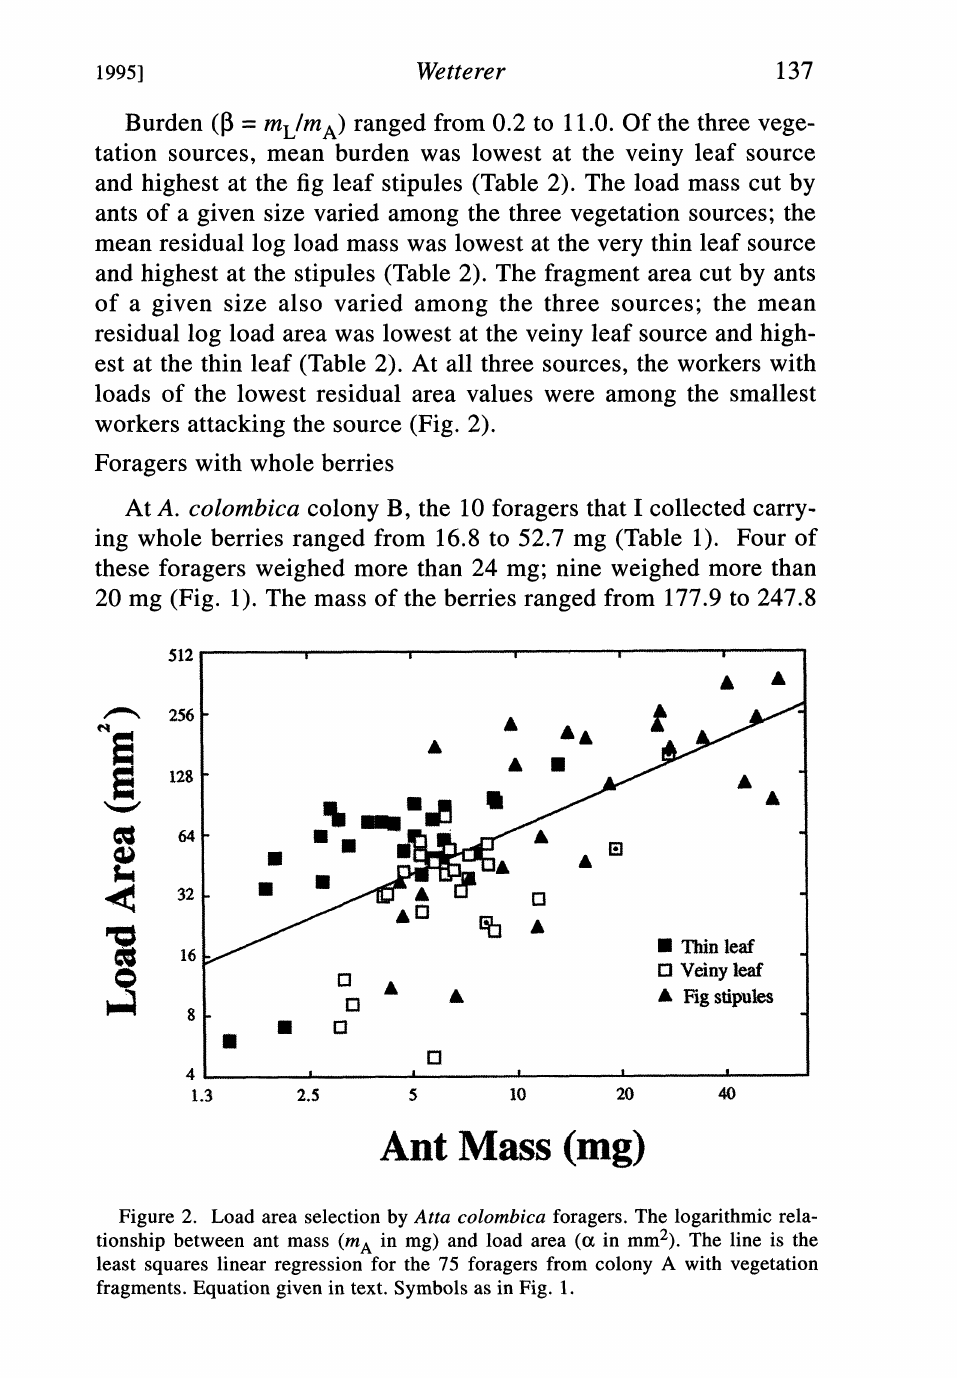
Figure 2. Load area selection by Atta colombica foragers. The logarithmic rela- tionship between ant mass (m A in mg) and load area (t in mm2). The line is the least squares linear regression for the 75 foragers from colony A with vegetation fragments. Equation given in text. Symbols as in Fig.